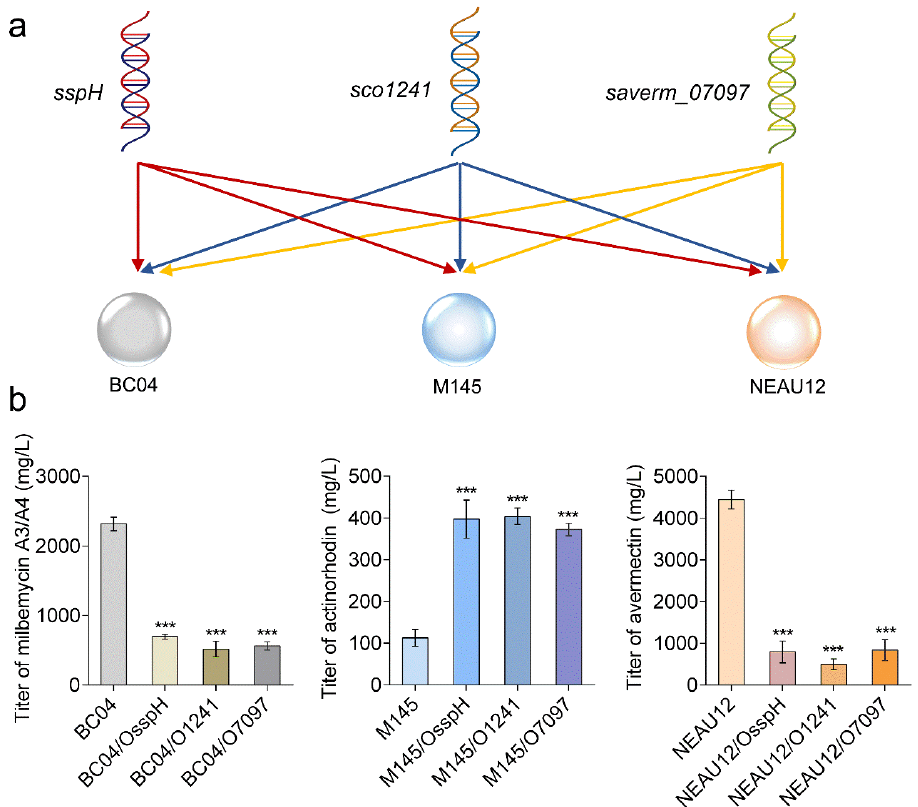
Figure 6. SspH and its orthologs are involved in modulating antibiotic production in three Strep- tomyces species. ( a ) Schematic diagrams of cross-overexpression of sspH , sco1241 and saverm_07097 in BC04, M145 and NEAU12. ( b ) Effects of overexpression of sspH , sco1241 and saverm_07097 on the titers of milbemycin A3/A4, actinorhodin and avermectin B1a in BC04, M145 and NEAU12. p -values were determined by Student’s t -test. *** p <